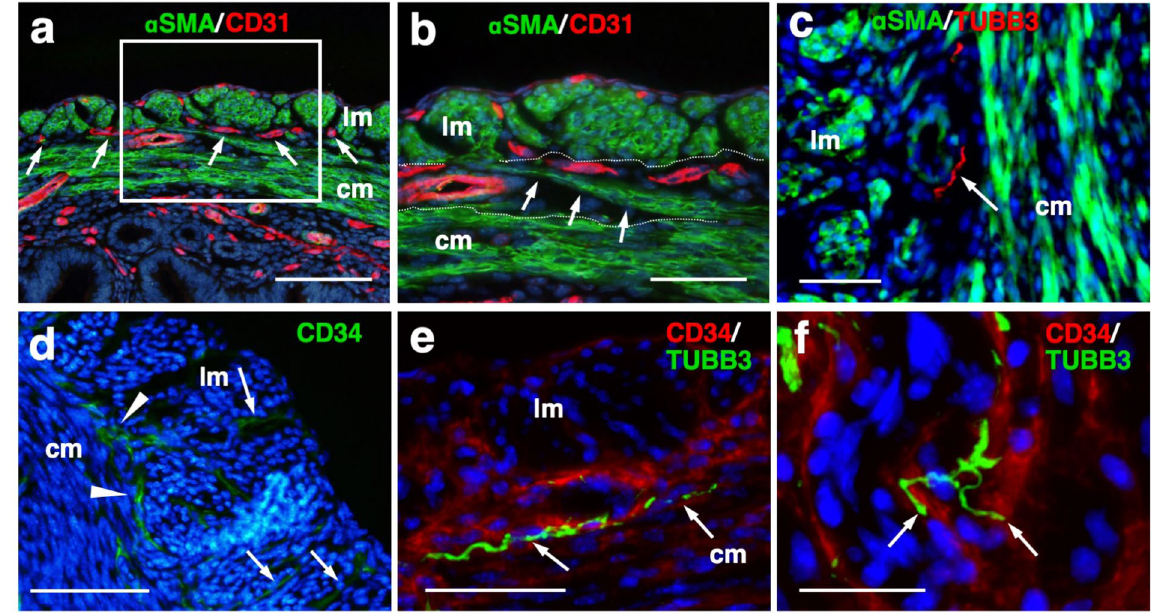
Figure 4. Immunohistochemical examination of the mesh-like muscle layer. Adult wild-type female mice were fixed with a transcardial perfusion of 4% PFA. Sections were stained with anti-CD31 ( a,b ), anti-TUBB3 ( c , e , f ), and anti-CD34 ( d–f ) antibody to investigate the cell populations in the mesh-like middle muscle layer. ( a ) CD31-positive endothelial cells (arrows) are abundant in the middle muscle layer. ( b ) A highly magnified image of the white square in ( a ). Muscle fibers (arrows) run across the vessel-rich region in the mesh-like layer (within the dotted lines). ( c ) Tubulin β -3 (TUBB3)-positive nerve axons were dominantly distributed within the mesh-like muscle layer. ( d ) CD34-positive myometrial telocytes that possess elongated thin telopods were predominant within the outer longitudinal layer (radially distributed, arrows) and the middle mesh-like layer (circularly distributed, arrowheads). ( e ) TUBB3-positive axonal fibers (arrows) were observed in parallel along the CD34-positive telocytes in the mesh-like muscle area. ( f ) These TUBB3-positive axonal terminals (arrow) were attached to CD34-positive telocytes. lm, longitudinal muscle layer; cm, circumferential muscle layer; α SMA, alpha smooth muscle actin; TUBB3, tubulin β -3. Scale bars, 100 µ m ( a ), 50 µ m ( b – e ), and 25 µ m ( f